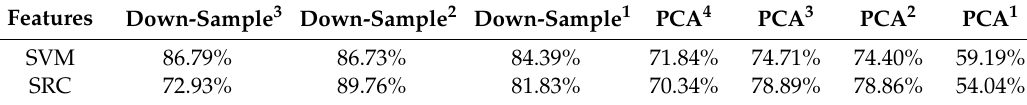
Table 3. The recognition accuracy under different unconventional feature spaces.